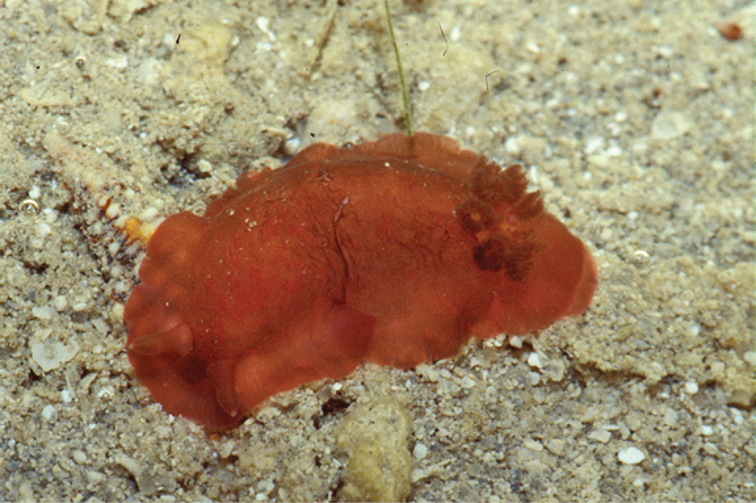
Dendrodoris fumata, Saudi Arabia, photo: F Krupp (no spcm).